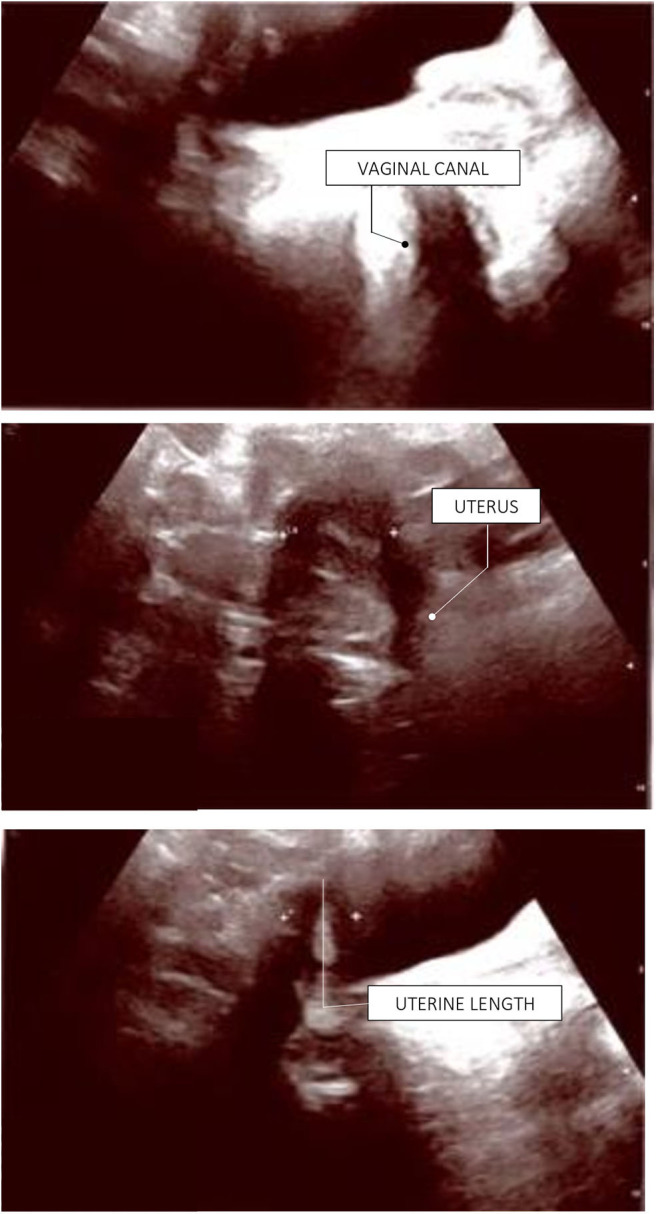
Proband's last pelvic ultrasound, performed at the end of the pubertal induction. Ovaries were not detected due to ovarian dysgenesis. The uterus has reached a mature post-pubertal shape and volume (9.5 mL). Endometrial thickness: 4 mm (secretive phase).